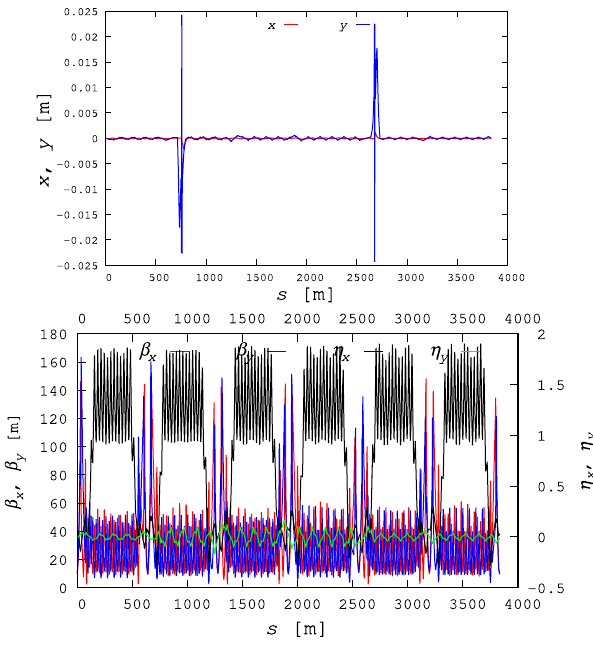
FIG. 11. Closed orbit (top) and optical functions (bottom) in RHIC Yellow ring lattice model at injection energy ( G γ ¼ 45 . 5 ), with snake lattice elements represented by their OPERA field maps and including the local centering